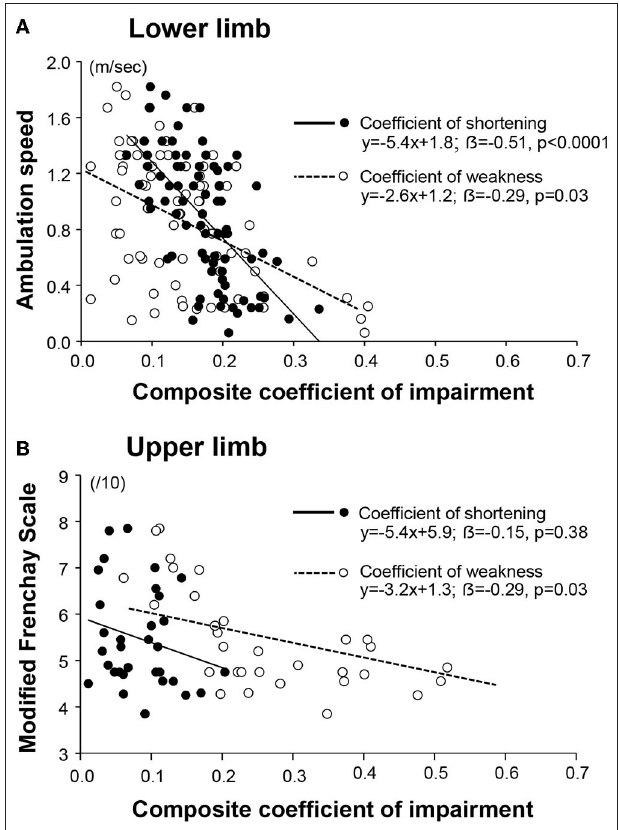
FIGURE 6 | Respective contribution of the muscular and the neurological disorders to functional impairments. The coefficient of impairment refers to the coefficient of shortening or the coefficient of weakness, as indicated in the legend. The composite coefficient is the mean of the individual coefficients for each of the six muscles of the lower limb (A) ; and of the upper limb (B)